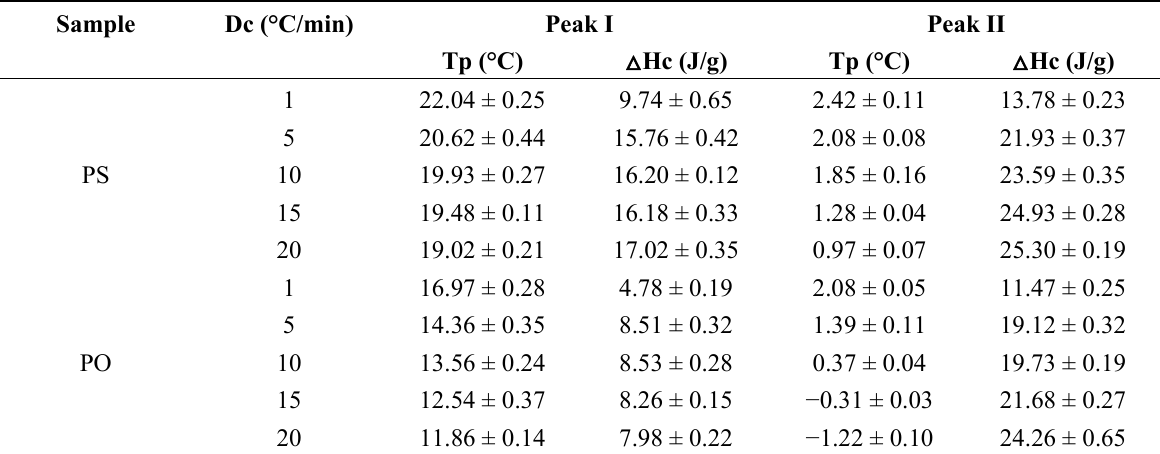
Table 2. Peak temperature(Tp)and enthalpy variation( Δ Hc) of PS and PO with different cooling rate.